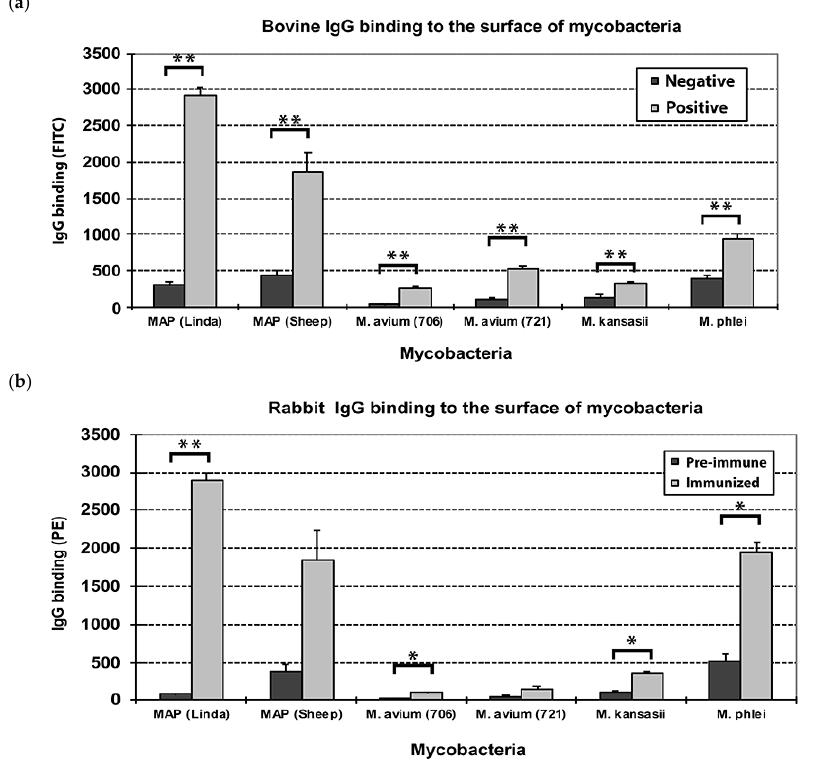
Figure 1. Antibody binding to intact mycobacteria with bovine and rabbit antisera. ( a ) Shown are the results from 5 Johne’s disease (JD)-positive (gray bars) and 5 JD-negative cows (black bars) against different species and subspecies of mycobacteria. ( b ) Sera from 2 rabbits immunized with the Map K-10 EtOH extract shows a similar pattern to what was observed with sera from cattle with JD. The pre-immune serum is represented by black histogram bars and post-immune serum is the gray bars. Error bars represent standard deviation of the means. M. avium (706) is TMC706 and M. avium (721) is TMC721, a strain isolated from a child’s lymph node and is serotype 3. Significance is denoted by asterisks, * = p < 0.01; * * = p <